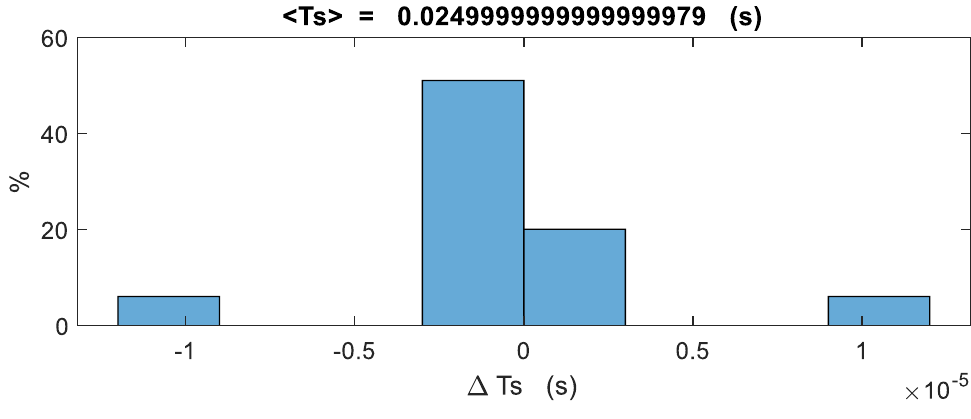
Figure 4. Error distribution of sampling period T S .